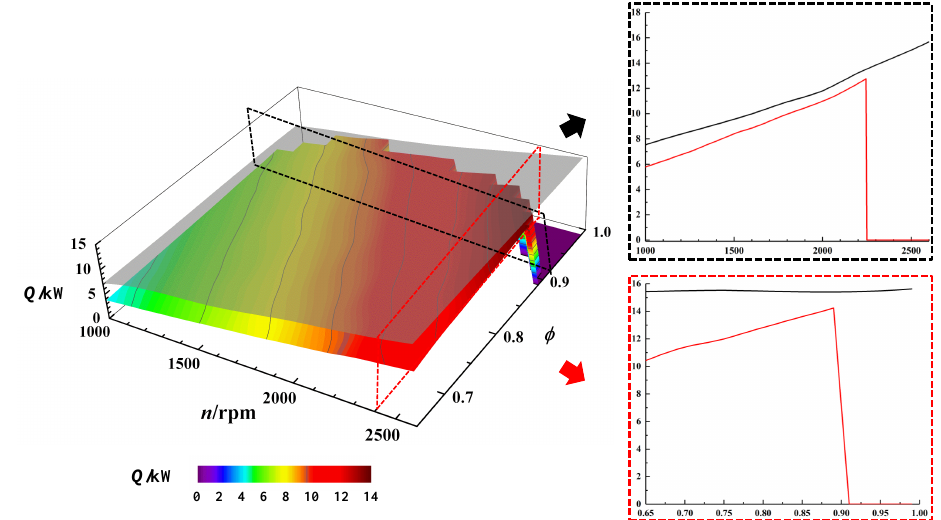
Figure 10. The plot ensures that the cooling system works well in all cases. The gray surface representing Q c in Equation (14) is just above the colorful surface, which represents the heat rejection Q of the